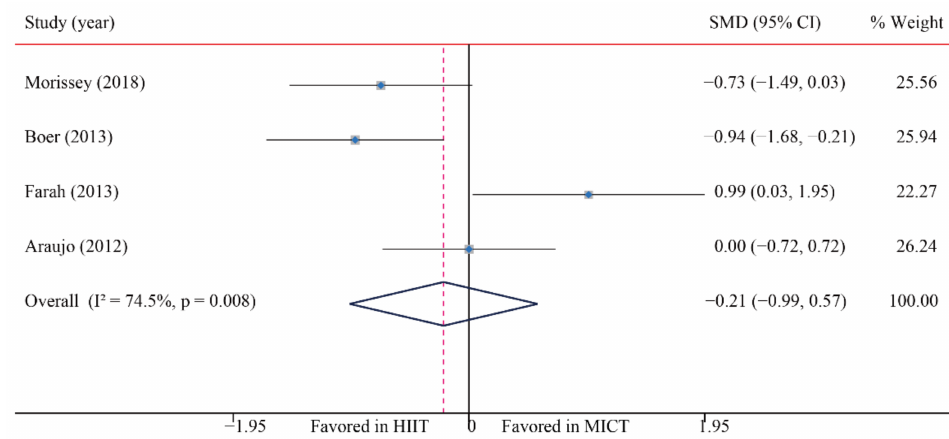
Figure 15. Effect of HIIT versus MICT on blood